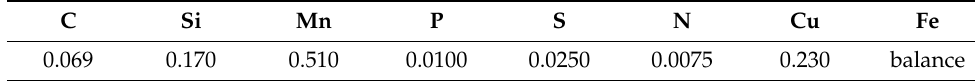
Table 1. Chemical composition (wt.%) of S235JR steel (manufacturer specification).